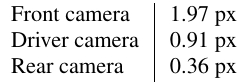
Table 3: RMS values of the single camera calibration using a pinhole model for each vehicle